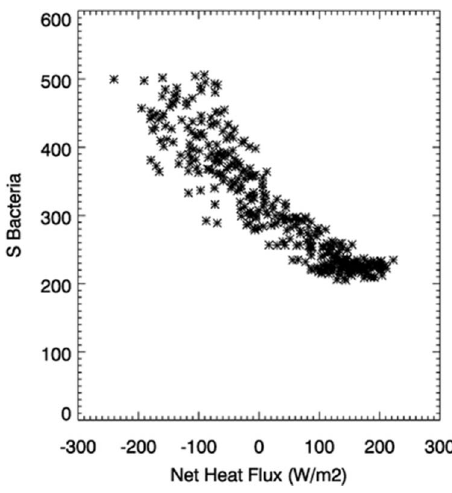
Figure 4. Bacterial diversity versus the magnitude of NHF for station L4 (r= 2 0.920). Each individual data point represents a daily average for the period 2003–2008.